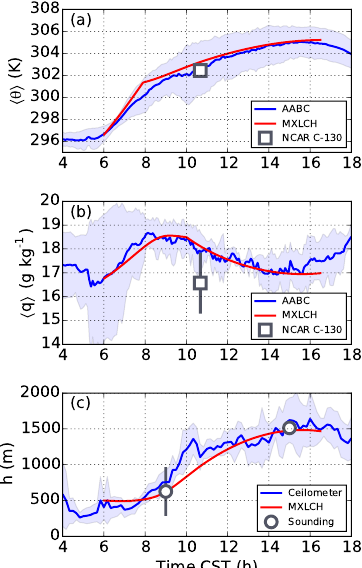
Figure 4. Diurnal evolution of (a) mixed-layer potential tempera- ture ( (cid:104) θ (cid:105) ), (b) mixed-layer specific humidity ( (cid:104) q (cid:105) ), and (c) boundary layer height ( h ). The solid blue lines indicate ground-based observa- tions which are averaged over the low cloud cover days. The shaded areas and error bars indicate 1 standard deviation of the correspond- ing observations. The solid red lines indicate data from MXLCH